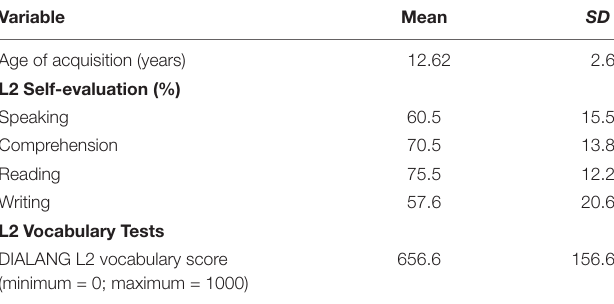
TABLE 1 | Age of acquisition and L2 proficiency of participants (n = 24): using a questionnaire, participants were asked to indicate in percentage terms how well they would estimate their English reading, speaking, comprehension, and writing skills.